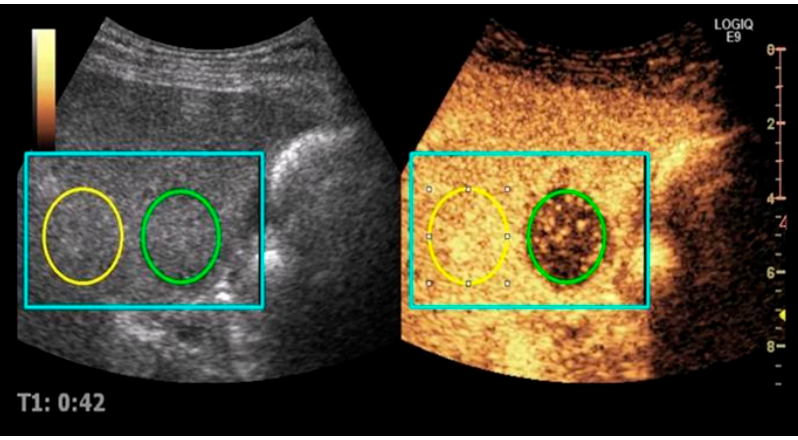
Figure 1. Split view of simultaneous imaging with contrast enhanced imaging on the right and B-mode on the left. Region of interest (ROI) is placed within the metastasis (green) and in normal liver tissue (yellow). The blue frame illustrates analysis area with motion correction.